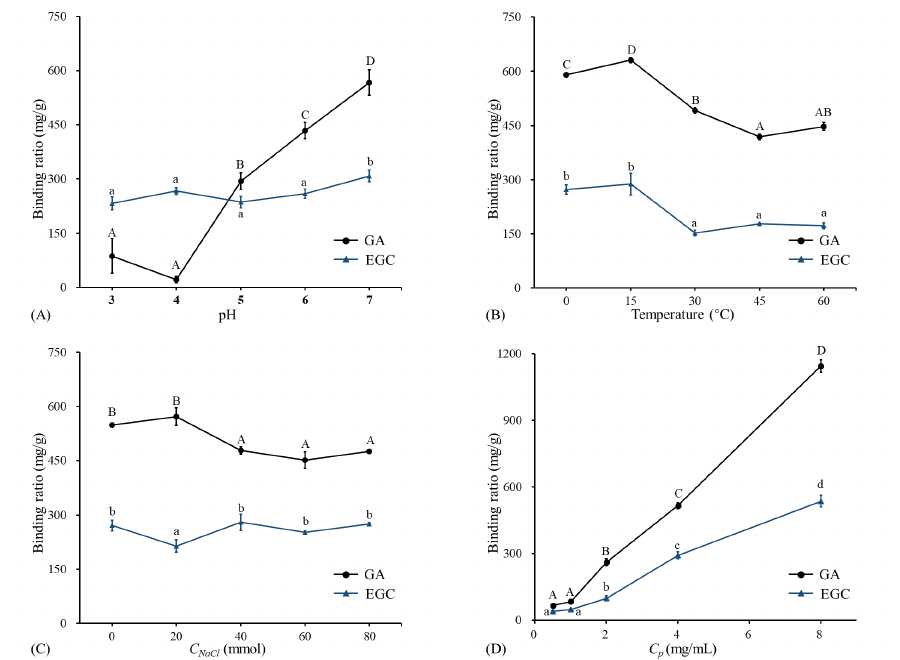
Figure 2. The binding ratios of GA and EGC to LRPs at different pH, temperatures, NaCl concen- trations, and phenol concentrations. ( A ) The binding ratios of GA and EGC to LRPs at different pH, temperature of 15 °C, and mass ratio of GA/EGC to LRPs of 2:1; ( B ) the binding ratios of GA and EGC to LRPs at different temperatures, pH 7, and mass ratio of GA/EGC to LRPs of 2:1; ( C ) the binding ratios of GA and EGC to LRPs at different NaCl concentrations, pH 7, temperature of 15 °C, and mass ratio of GA/EGC to LRPs of 2:1; ( D ) the binding ratios of GA and EGC to LRPs at different C p phenol concentrations (different mass ratios of GA/EGC to LRPs of 1:4, 1:2, 1:1, 2:1, 4:1), pH 7, and temperature of 15 °C. Means of the samples with different letters (A–D, a–d) differ significantly ( p <